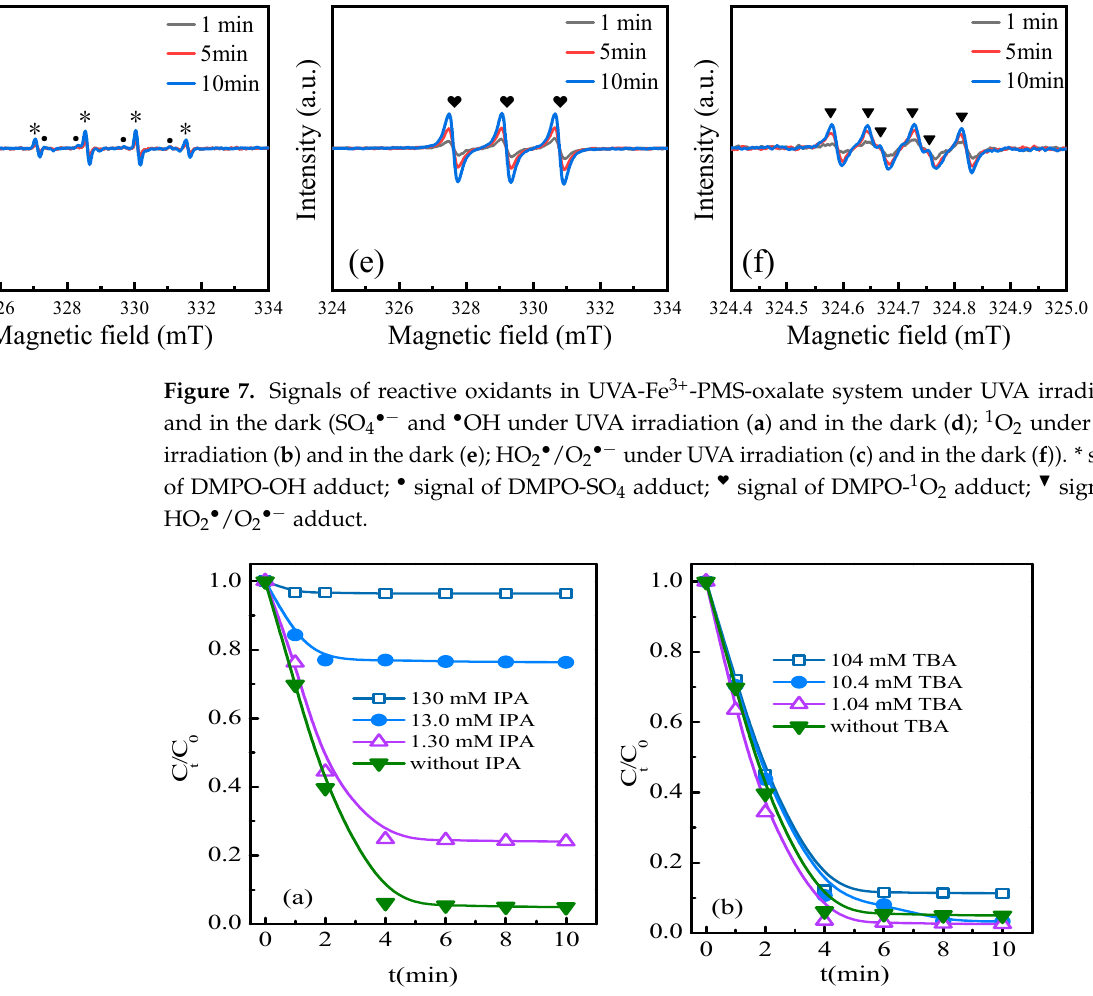
Figure 8. The effects of IPA ( a ) and TBA ( b ) on the decolorization of Orange ([Fe 3+ ] 0 = 100 µM, [Orange II] 0 = 50 µM, [PMS] 0 = 150 µM, [oxalate] 0 = 80 µM, under UVA irradiation, λ irr. = 365 nm, pH 3).